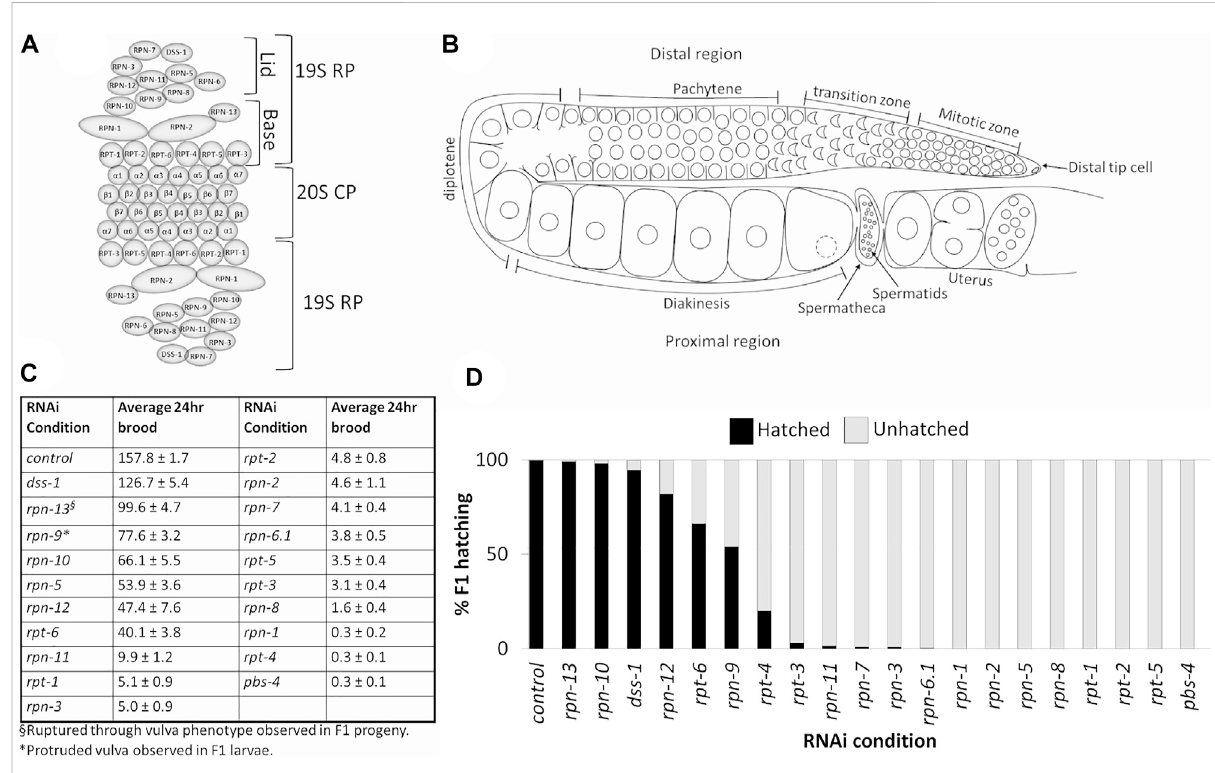
FIGURE 1 Depletion of 19S RP subunits of the 26S proteasome in C. elegans hermaphrodites causes reduced 24 h brood and/or embryonic lethality. (A) Schematic of eukaryotic 26S proteasome and its subunits. (B) Schematic of an adult C. elegans hermaphrodite germ line (one gonad arm). (C) Average 24 hbroodof C.elegans hermaphroditesRNAi-depleted of eitheracontrol gene( n = 152), anyofthe19 subunits of the19SRP( n =10 – 83), or a 20S CP subunit, PBS-4 ( n = 36). Brood is shown ±SEM and calculated from at least three independent trials. All RNAi conditions compared to control exhibit a p -value < 0.0001. (D) Percent of hatched (black bars) and unhatched (grey bars) progeny of hermaphrodites treated with either control(RNAi) or the indicated proteasome subunit(RNAi)